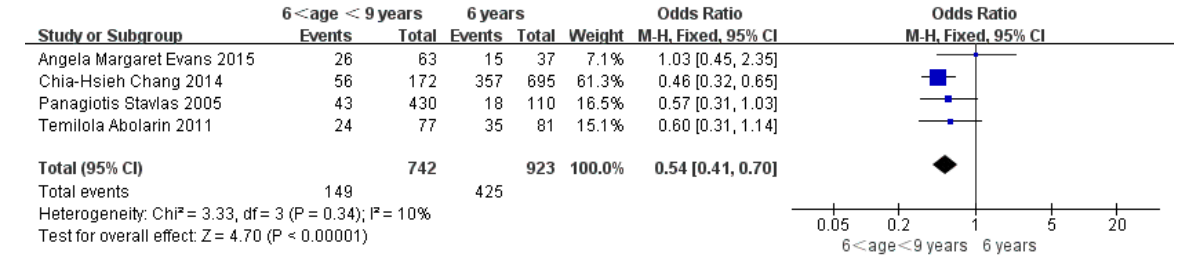
Figure 2. The forest plot of age <6 years for flatfoot in children [8,12,14,17].